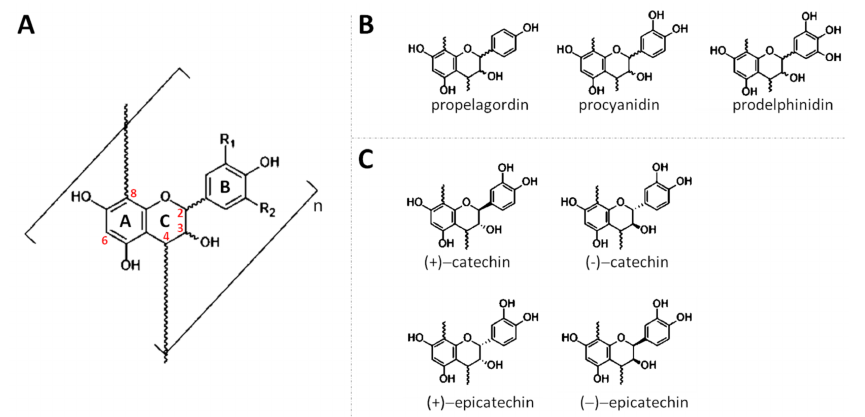
Figure 1. Chemical structures of some PAC monomers. Panel ( A ) shows the general chemical structure of flavan-3-ol monomers; Panel ( B ) shows a monomer of propelagordin, procyanidin, and prodelphinidin, which differ from each other in regard to the number and/or position of hydroxyl groups on the B-ring; Panel ( C ) shows the chemical structure of catechin and epicatechin, along with the respective enantiomers, which are different from each other in regard to the stereochemistry of flavonol heterocycle.